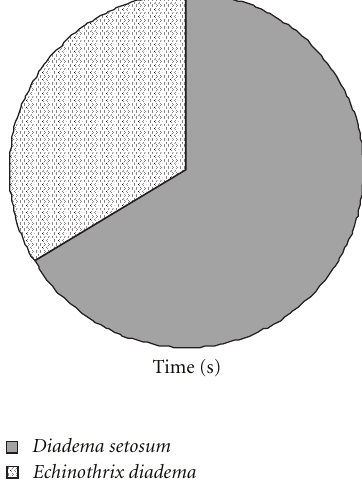
Figure 3: Organic matter as measured in August 2008. Treatments consisted in caged settlement plates (T0 n = 21), noncaged settlement plates (out n = 20), and settlement plates removed from the cages and exposed to grazing for 2h (T1 n = 14) and 11h (T2 n = 13). Grey columns: day exposure, black columns: night exposure.